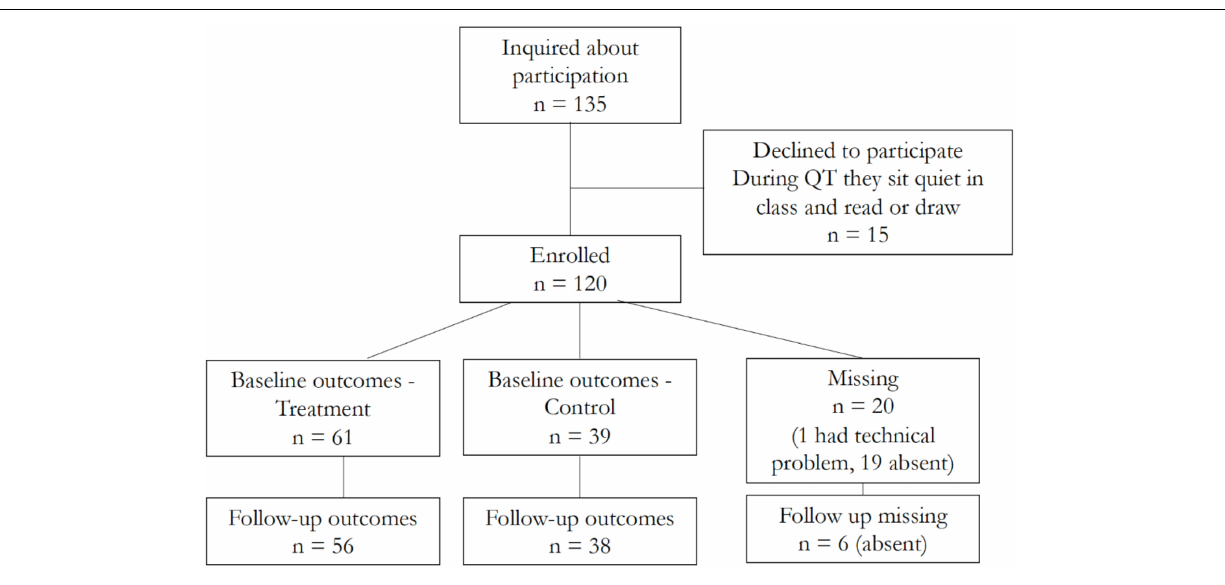
FIGURE 4 | CONSORT flow diagram - Ireland